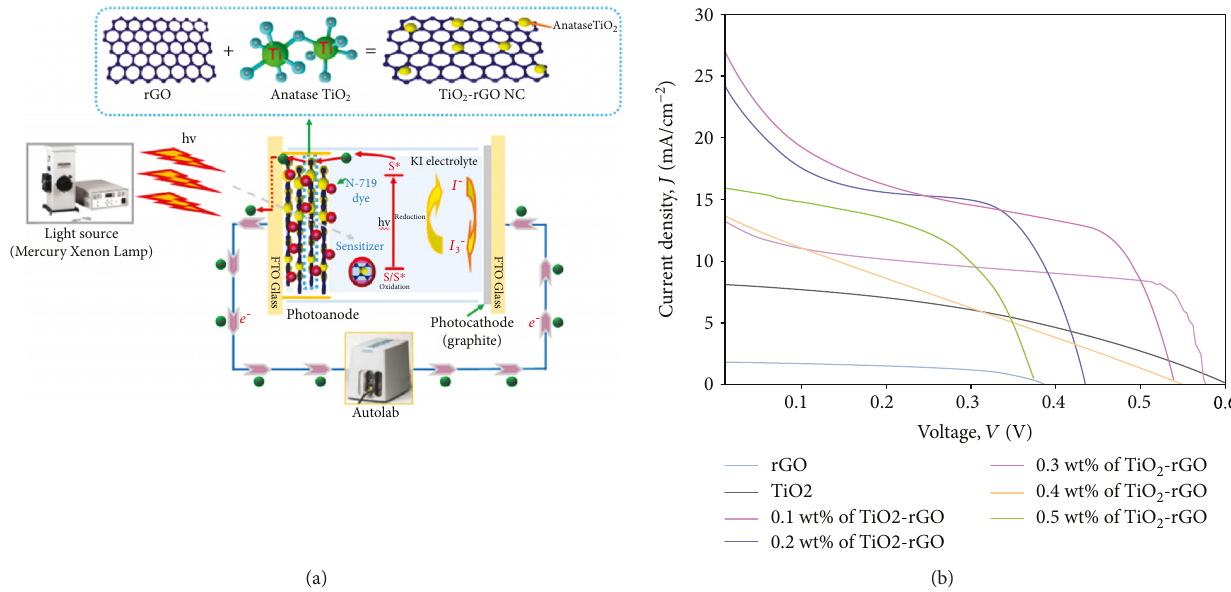
– rGO NC-based-DSSCs. (b) J – V curves of DSSCs under AM 1.5 condition with rGO, TiO Figure 7: (a) Schematic of TiO 2 – rGO amounts of TiO 2